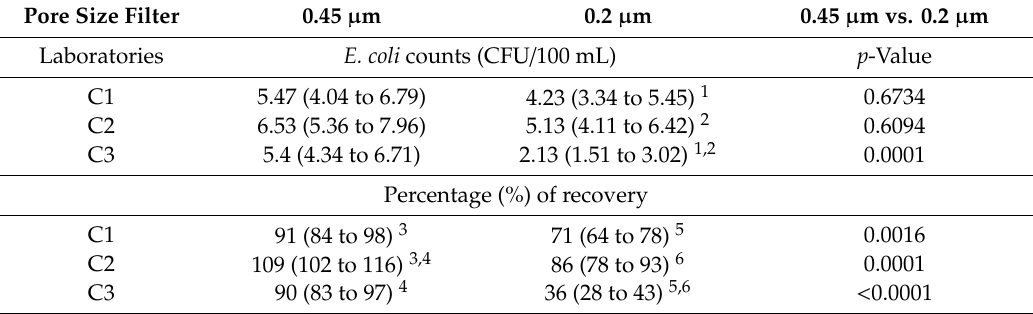
Table 2. Escherichia coli experiment: averages and 95% confidence intervals for each laboratory and type of membrane filter. p -values from the generalized model were adjusted according to Tukey.